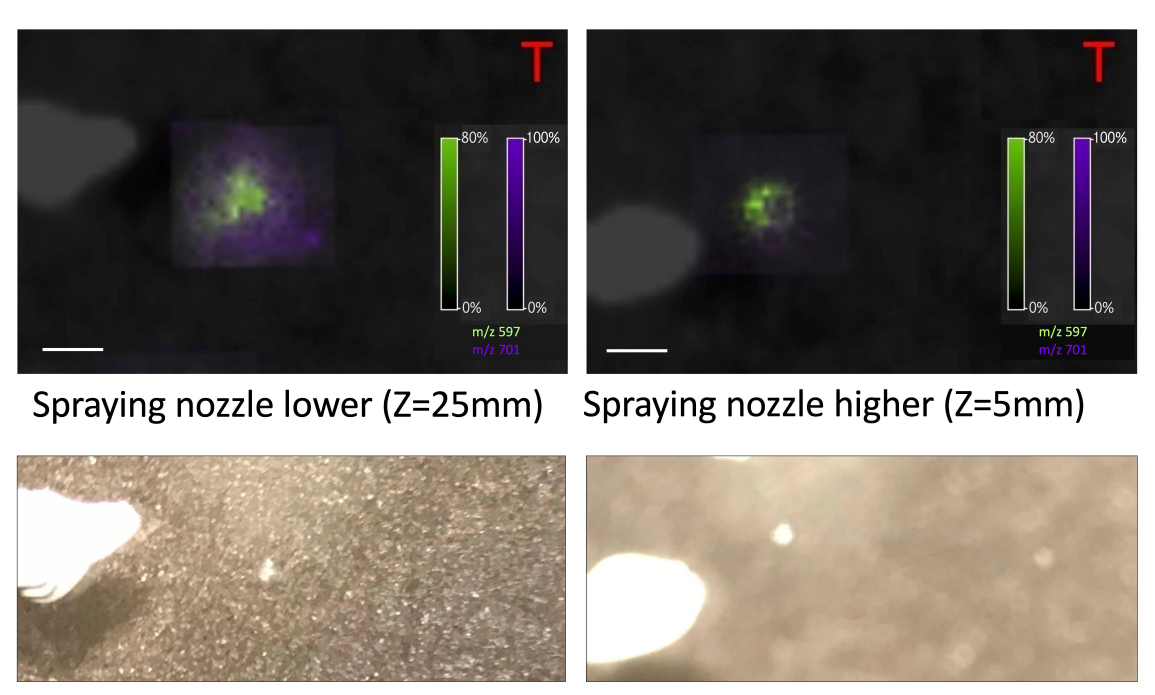
Figure 10. The picture of the oocyte obtained after matrix application at a lower nozzle position (Z = 25 mm) and higher nozzle position (Z = 5 mm), for the negative ionization mode, size bar: 200 µ m. Below it is presented the microscopic image of